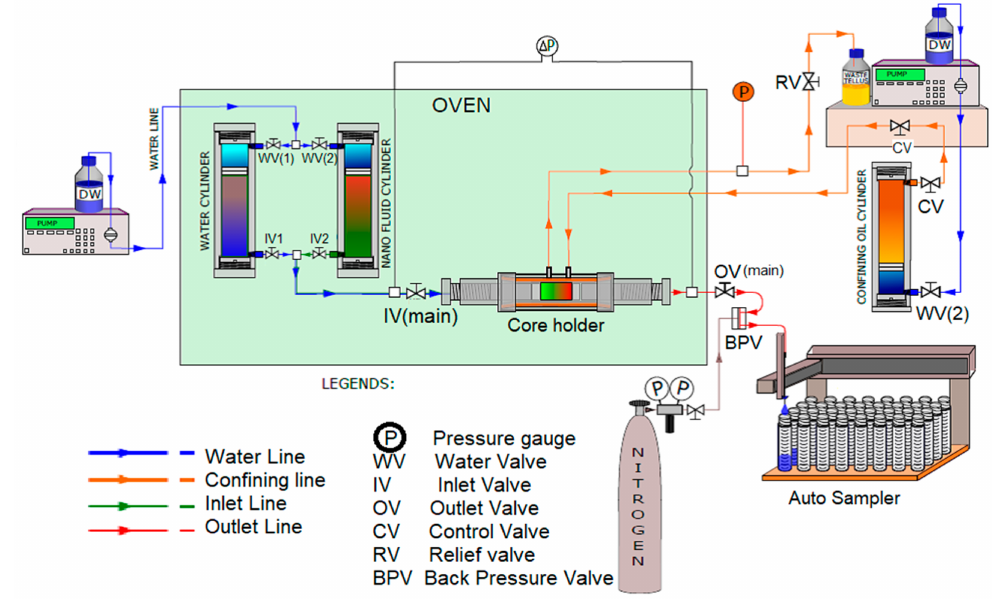
Figure 1. Schematic of the core flooding setup.